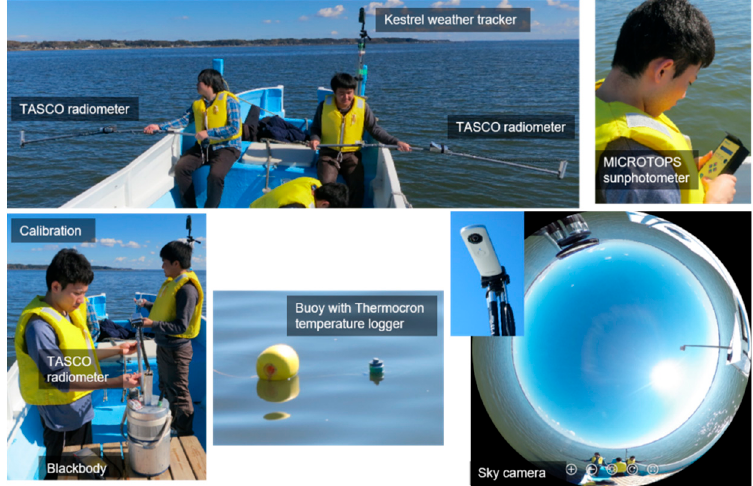
Figure 3. Photos from the vicarious calibration (VC) experiment conducted in Lake Kasumigaura on 2 November 2018.